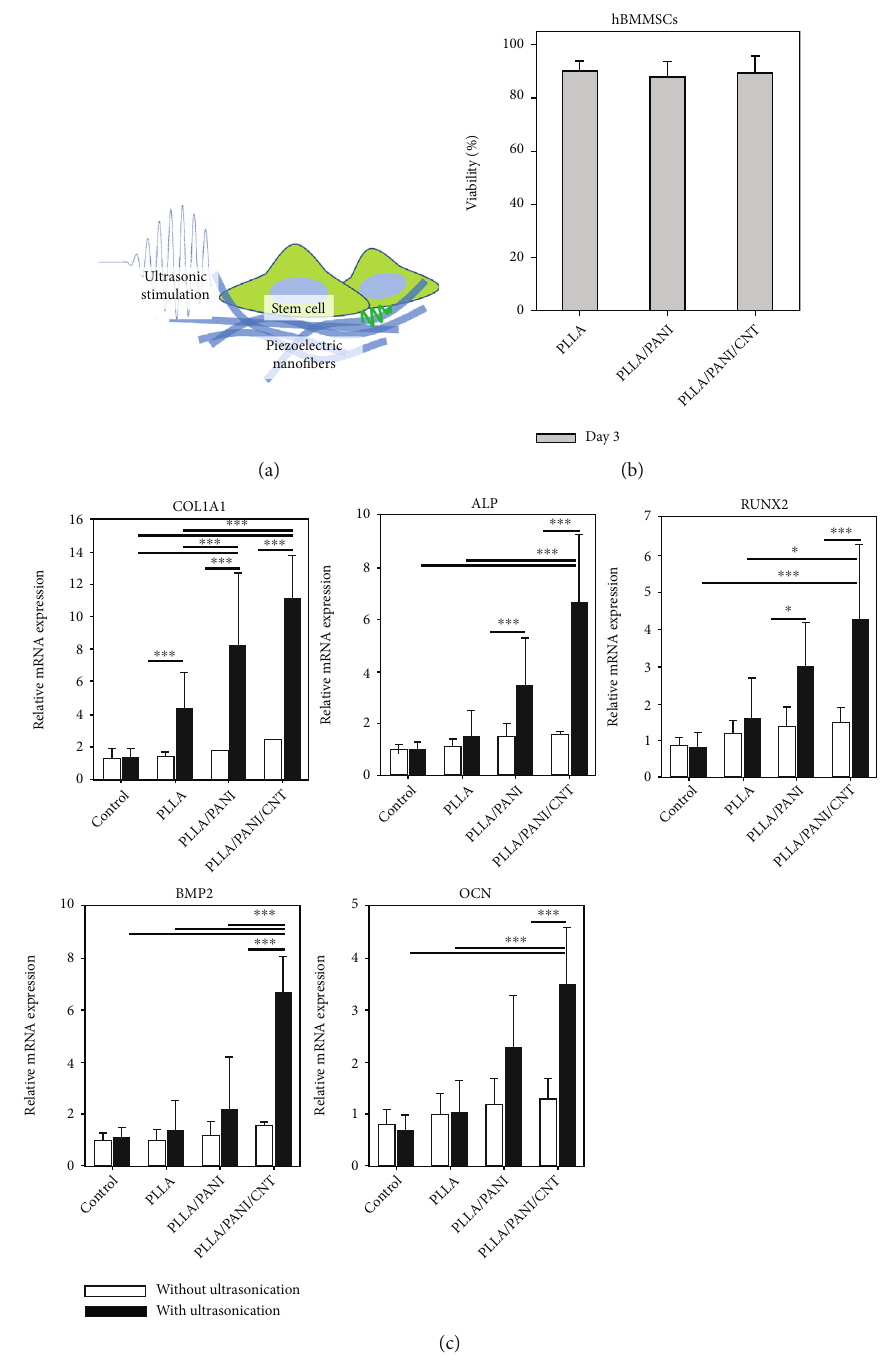
Figure 7: (a) Schematic representation of the ultrasound stimulation of stem cells cultured on nano fi brous sca ff olds. (b) The viability of hBMMSCs on PLLA, PLLA/PANI, and PLLA/PANI/CNT nano fi brous sca ff olds after being cultured for 3 in presence of ultrasound stimulation. (c) Analysis of gene expression pro fi les of osteogenic markers. Real-time polymerase chain reaction (qPCR) analysis of the osteogenic di ff erentiation of hBMMSCs cultured on PLLA-based nano fi brous after 4 weeks in osteogenic media in presence or absence